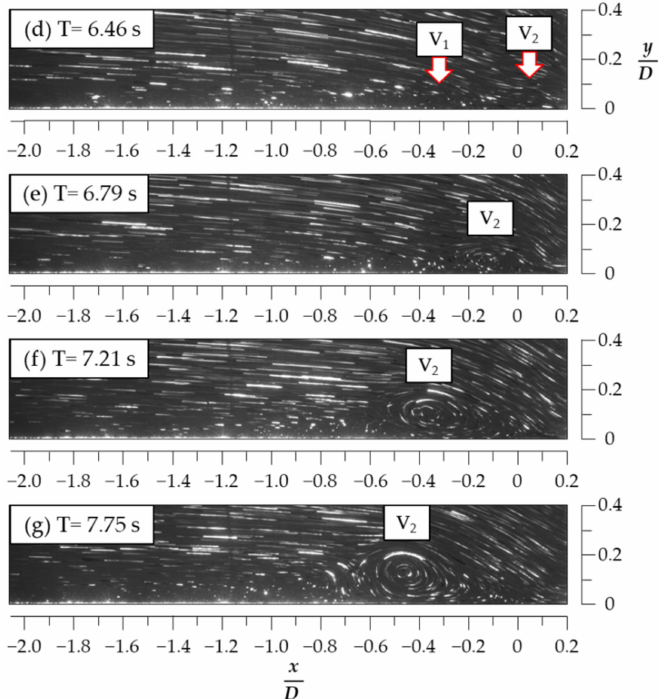
Figure 6. Time-series flow visualization of the HSV’s kinematic mode(s): “breakaway to roll-up” in the z = 0.4 cm plane when H / D = 0. From ( a ) to ( d ), the HSV denoted as V 1 was undergoing the “breakaway” process (mode); from ( d ) to ( g ), the HSV denoted as V 2 was rolling up and moving upstream to become a V 1 in the next mode that occurred.